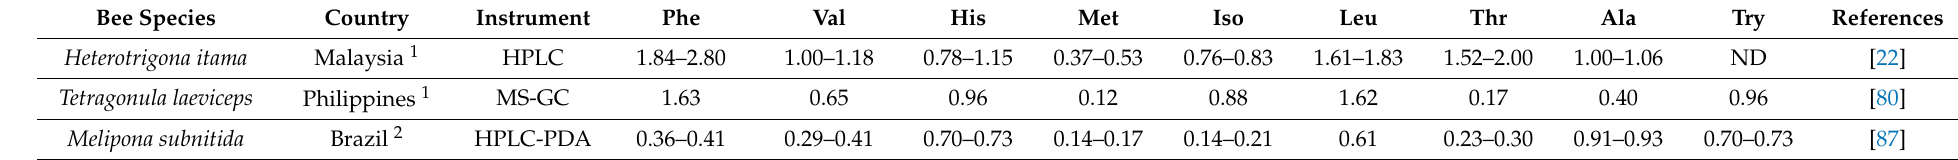
Table 2. Essential amino acid in stingless bee bee bread (g/100 g).